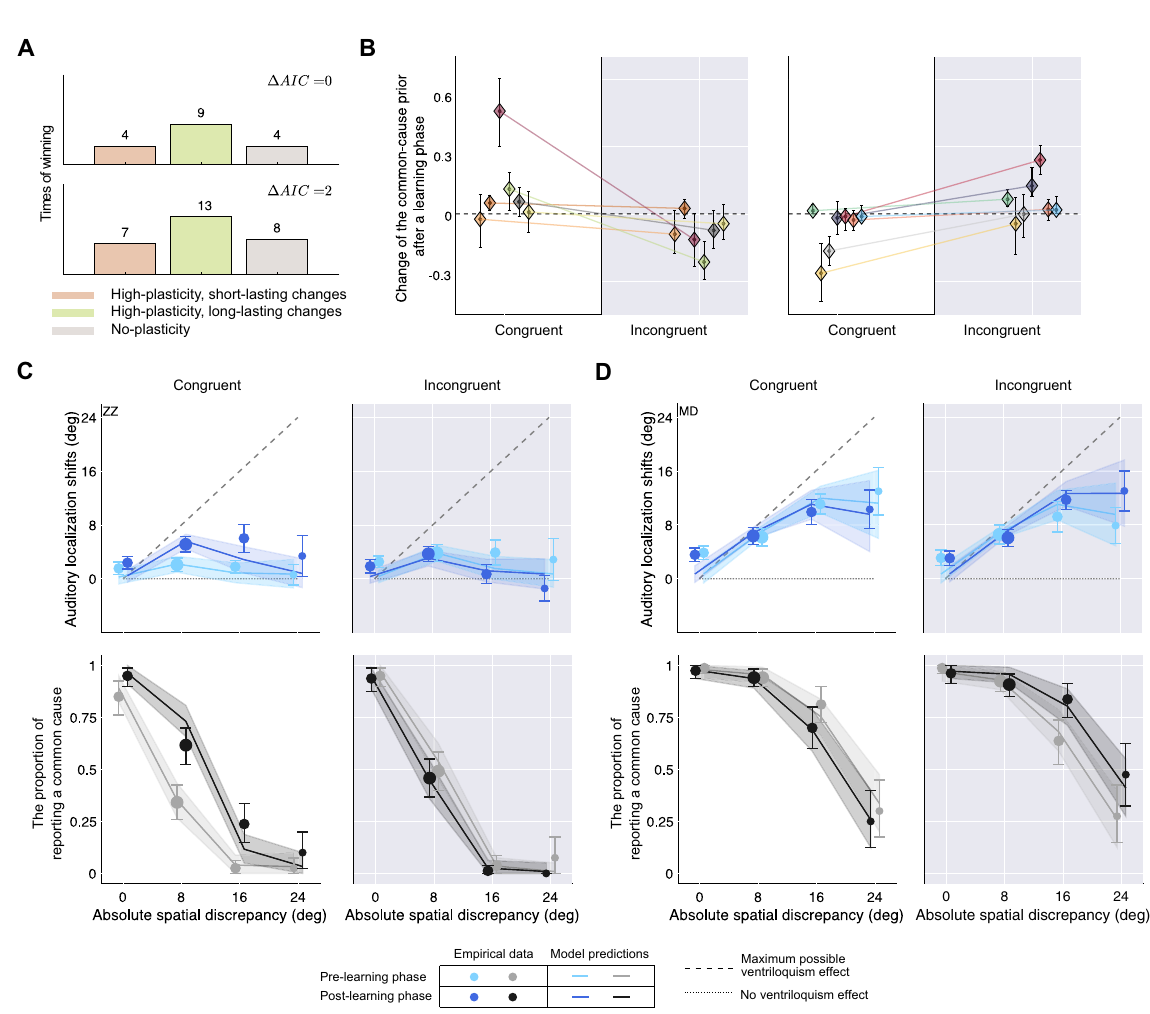
Figure 5. Model comparison and parameter estimates. ( A ) Results of two different model comparisons. Top panel: using a conservative criterion, there is only one best model, the one with the minimal AIC value; bottom panel: a liberal criterion selecting all models with an AIC value not exceeding the minimal AIC value by more than 2. ( B ) Change of the common-cause prior from the pre- to the post-learning phase as estimated by the best-fitting model. Color indicates individual participants. Participants are grouped according to the effect of the exposure phase on their common-cause priors (left panel: adaptation to the stimulus statistics, i.e., increases/ decreases of the common-cause prior after congruent/incongruent learning phases, right panel: the opposite pattern to that in the left panel). Error bars: 95% bootstrapped confidence intervals. Dashed line: no change of the common-cause prior after the learning phase. ( C ) Empirical data (dots) and model predictions (lines) for representative participant ZZ from the first group in ( B ). Auditory ventriloquism effects (top panels) and the proportion of common-cause reports (bottom panels) are plotted as a function of absolute spatial discrepancy for the pre- (lighter color) and post-learning phase (darker color). Error bars: ±2 SEM (top panel) and 95% binomial confidence intervals (bottom panels); shaded areas: 95% confidence intervals computed by parametric bootstrapping. ( D ) Empirical data and model predictions for representative participant MD from the second group in ( B ). Please see Appendix S4 for all